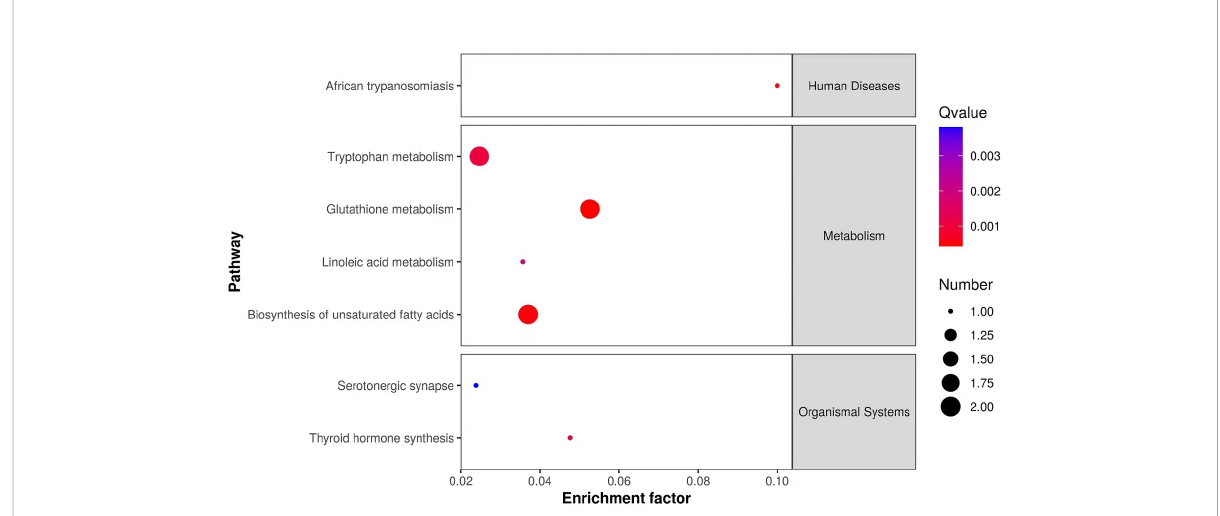
FIGURE 6 KEGG enriched pathways scatter plot of signi fi cantly changed secondary metabolites in liver tissues of juvenile fl ounder after MeHg exposure.